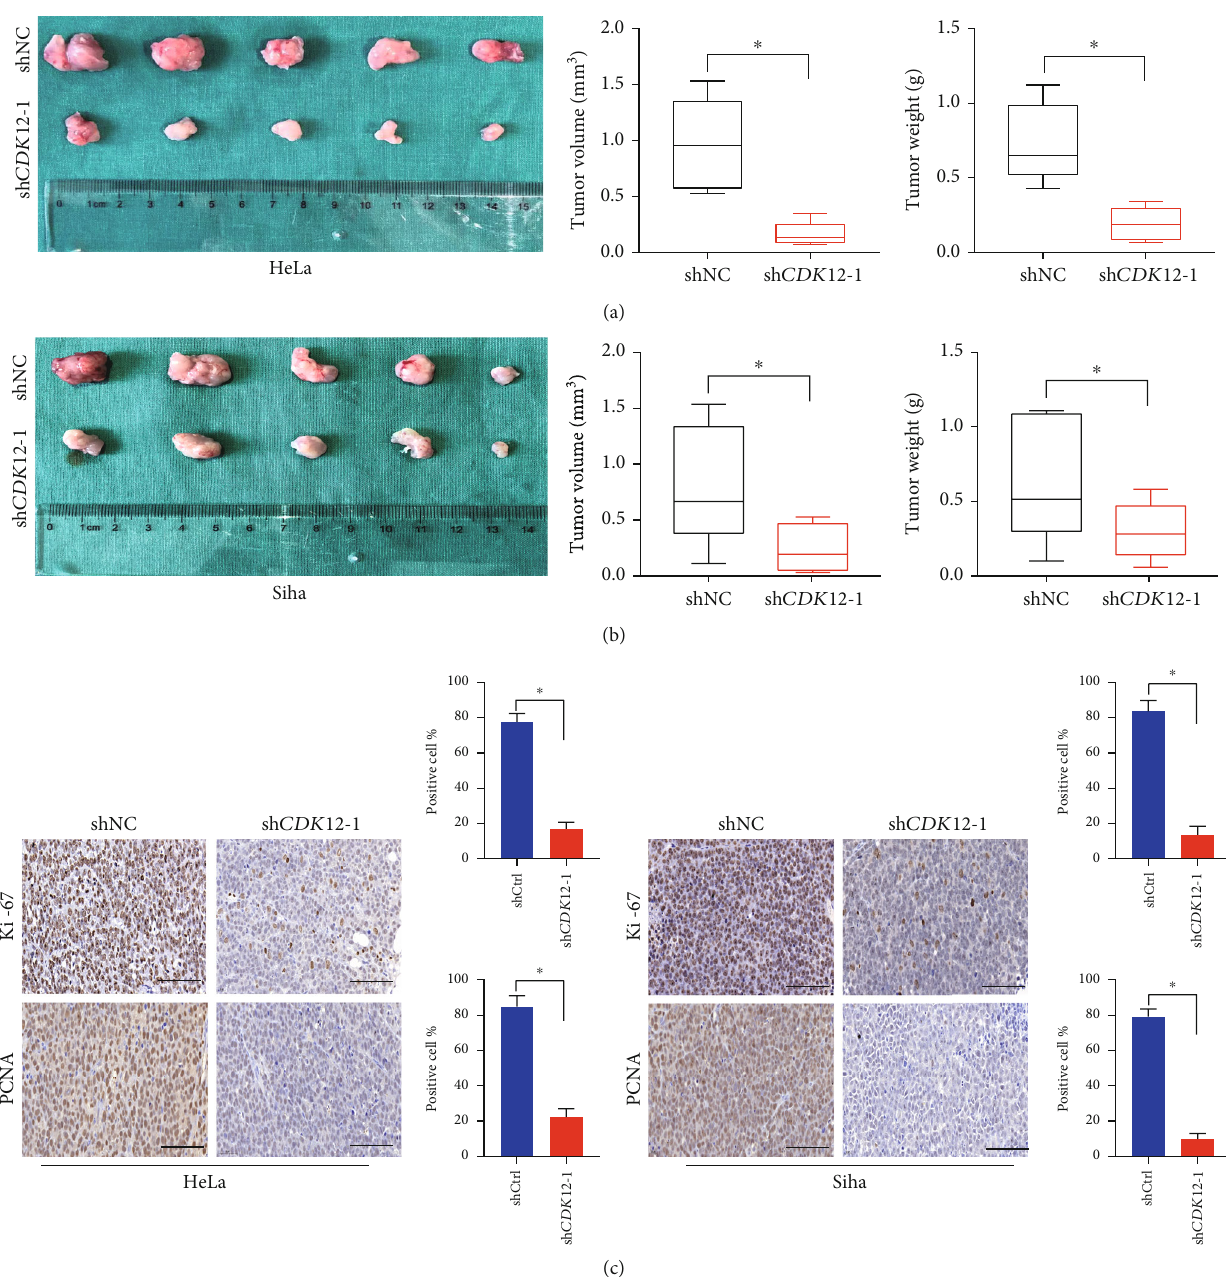
Figure 4: Knockdown of CDK12 suppresses tumor proliferation in vivo . (a), (b) HeLa and Siha cells were infected with sh CDK12 -1 and shNC and were injected into BALB/C nude mice. Excised tumor in di ff erent groups was shown. Four weeks later, tumor volumes and weights in sh CDK12 -1 were inhibited in comparison with shNC. (c) Typical IHC images of Ki67, and PCNA from xenografts under HeLa and Siha cells treatment with sh-NC and sh CDK12 -1. Two-tailed t -test, ∗ P < 0 : 05 . Scale bar: 50 μ